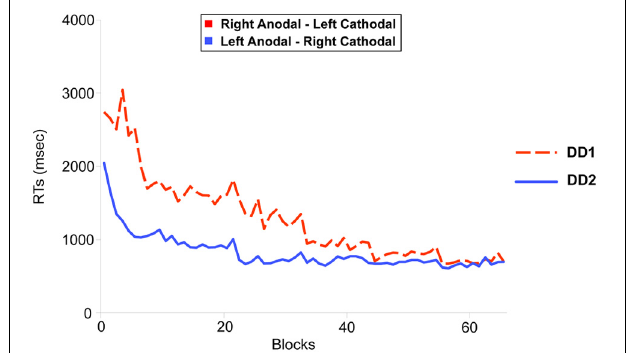
FIGURE 3 | Number Line task. Subjects were asked to map the given symbol, which appeared randomly at the left upper corner—as in the current example—or at the right upper corner, on the physical line. Subjects were instructed to place each symbol on the line according to its magnitude. Reprinted from Cohen Kadosh et al. (2010), with permission from Elsevier.